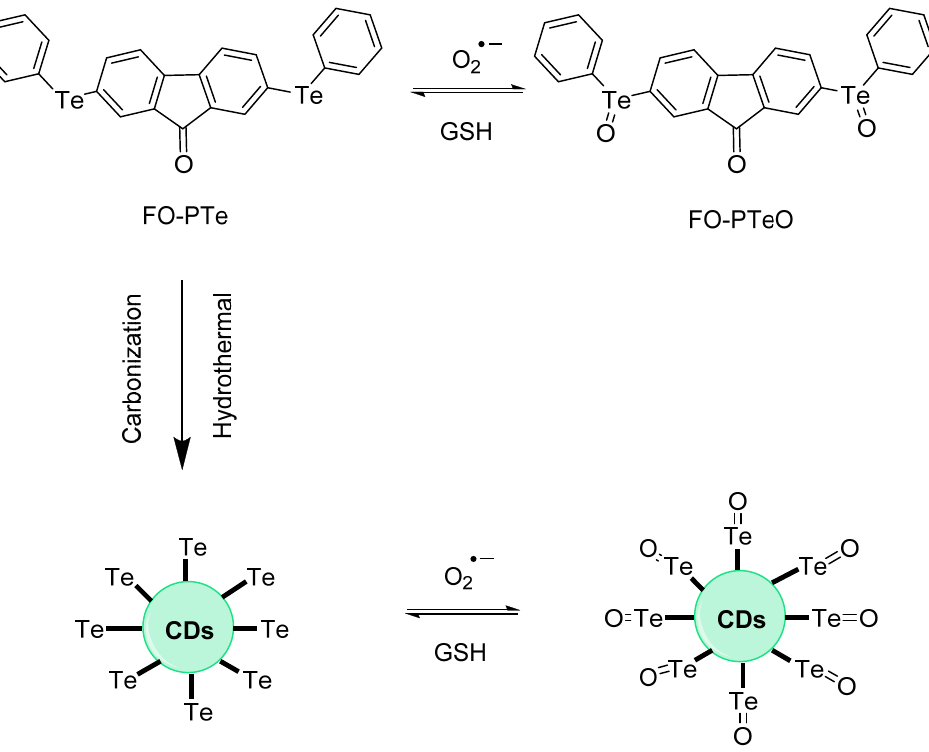
Figure 63. Oxidation of tellurium by superoxide and its reversible reaction with glutathione in carbon dots by Zhang et al.